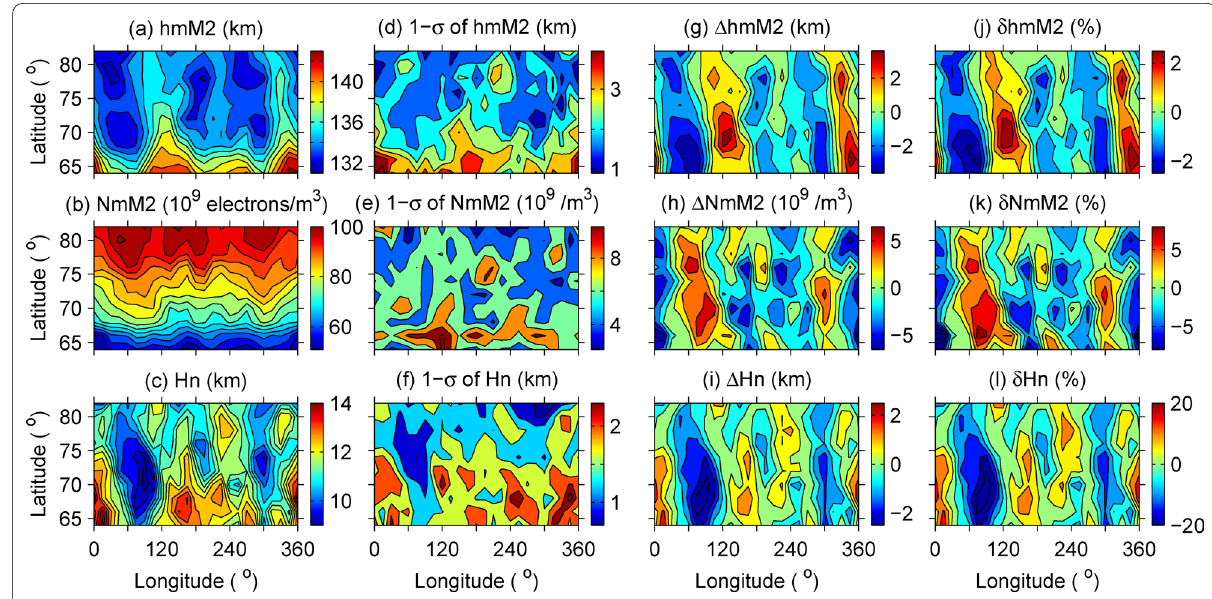
Fig. 3 Longitude and latitude variations of h m M 2 , N m M 2 , and H n . a – c present the gridded mean h m M 2 , N m M 2 , and H n , respectively; d – f are standard deviations of the gridded h m M 2 , N m M 2 , and H n , respectively; g – i show the residual h m M 2 , N m M 2 , and H n , respectively, after removing zonal averages; j – l are percentage longitude variations of h m M 2 , N m M 2 , and H n , respectively, with respect to zonal